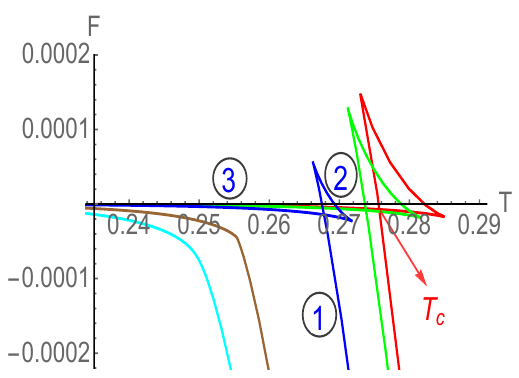
Figure 24 . Free energy as a function of T for various values of (cid:22) . Here red, green, blue, brown and cyan curves correspond to (cid:22) = 0, 0 : 1, 0 : 2, 0 : 312 and 0 : 35 respectively. In units